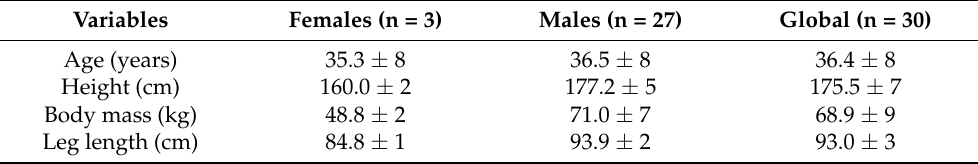
Table 1. Avg ± SD of the physical characteristics of women, men, and all participants.